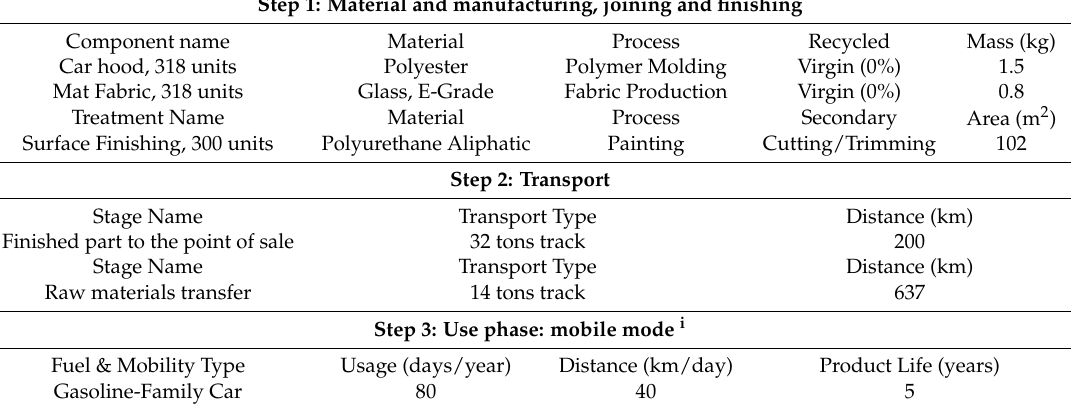
Table 9. Eco-Audit tool